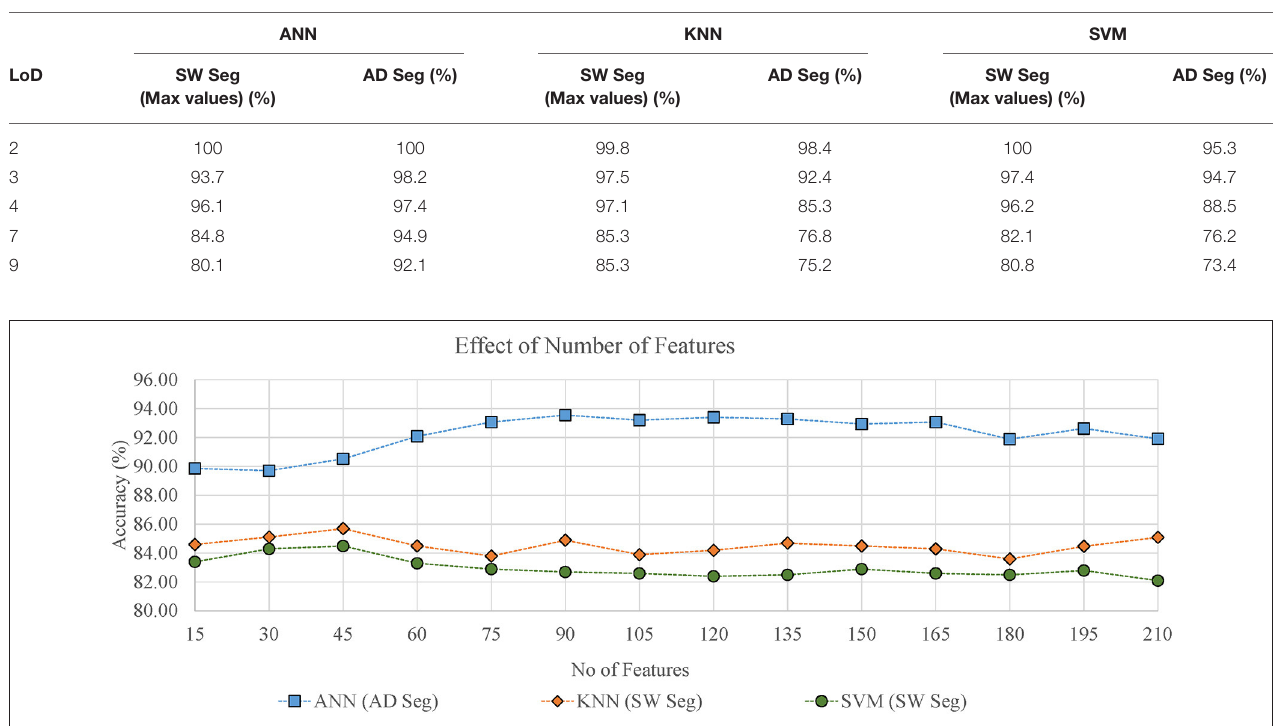
FIGURE 9 | Performance of classifiers using different feature subsets for